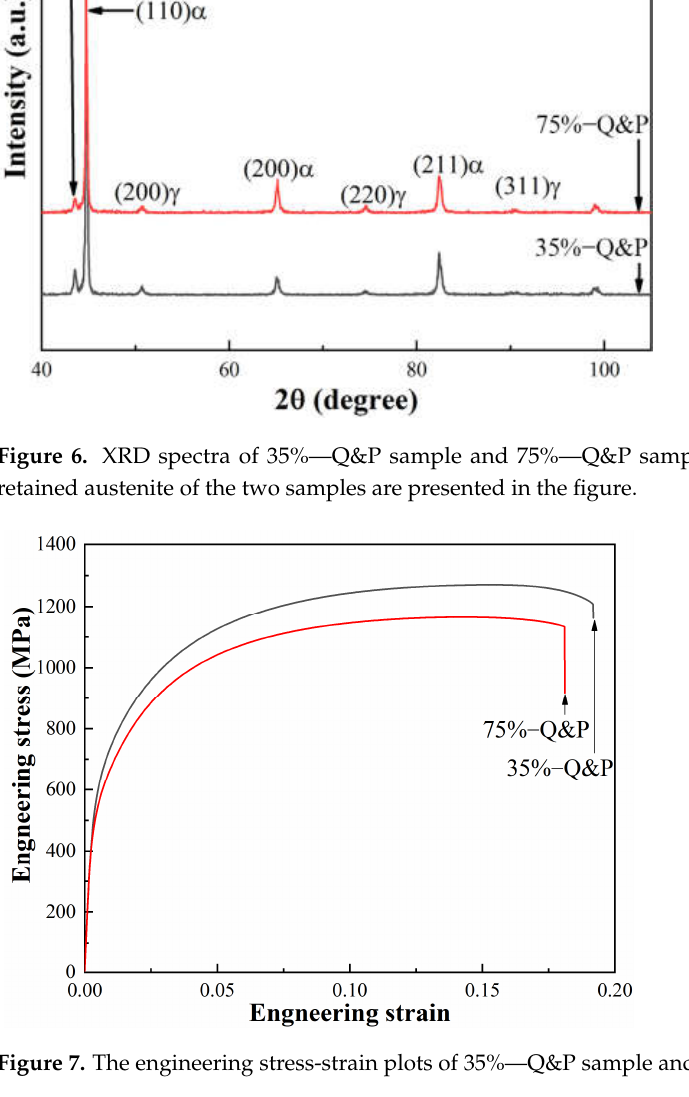
Figure 6. XRD spectra of 35%−Q&P sample and 75%−Q&P sample. The volume fractions of retained austenite of the two samples are presented in the figure.